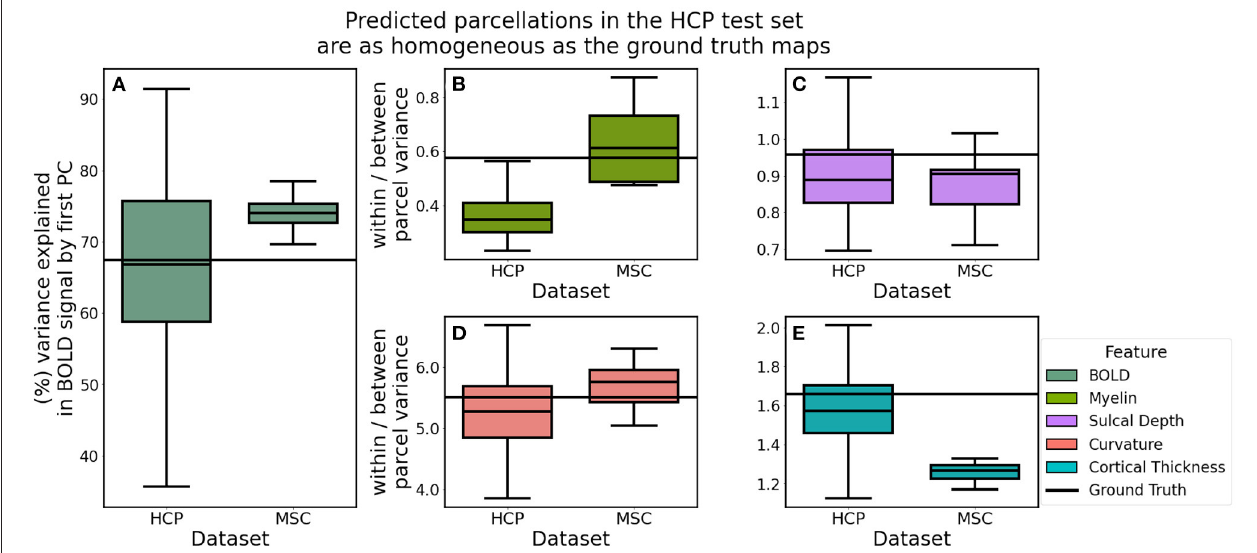
FIGURE 8 | Homogeneity of predicted parcellations in the HCP and MSC datasets using the optimal model. (A) Predicted parcels in the HCP test set explained as much variability in the functional connectivity as the ground truth parcels. (B–E) Predictions in the MSC had more variable myelin content and less variable cortical thickness estimates, relative to the HCP